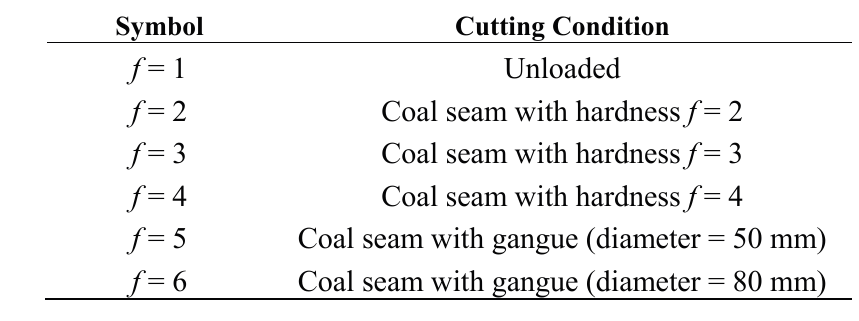
Table 1. Description of shearer drum cutting conditions.